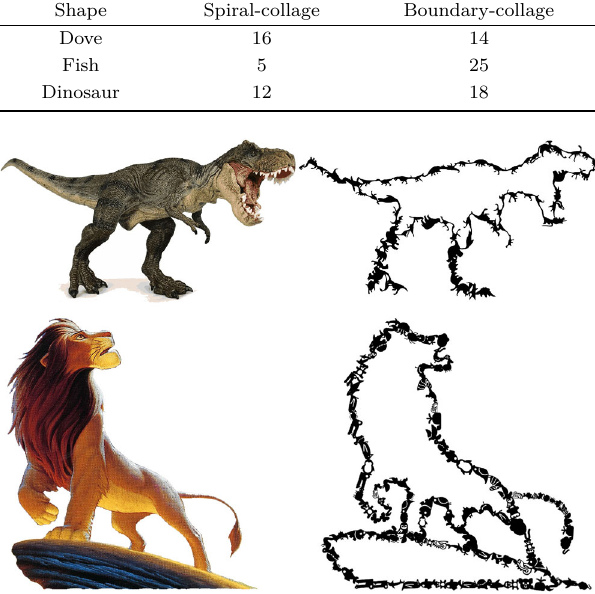
Fig. 12 Results with patterns in different groups from our pattern library. Left: reference images, right: collage